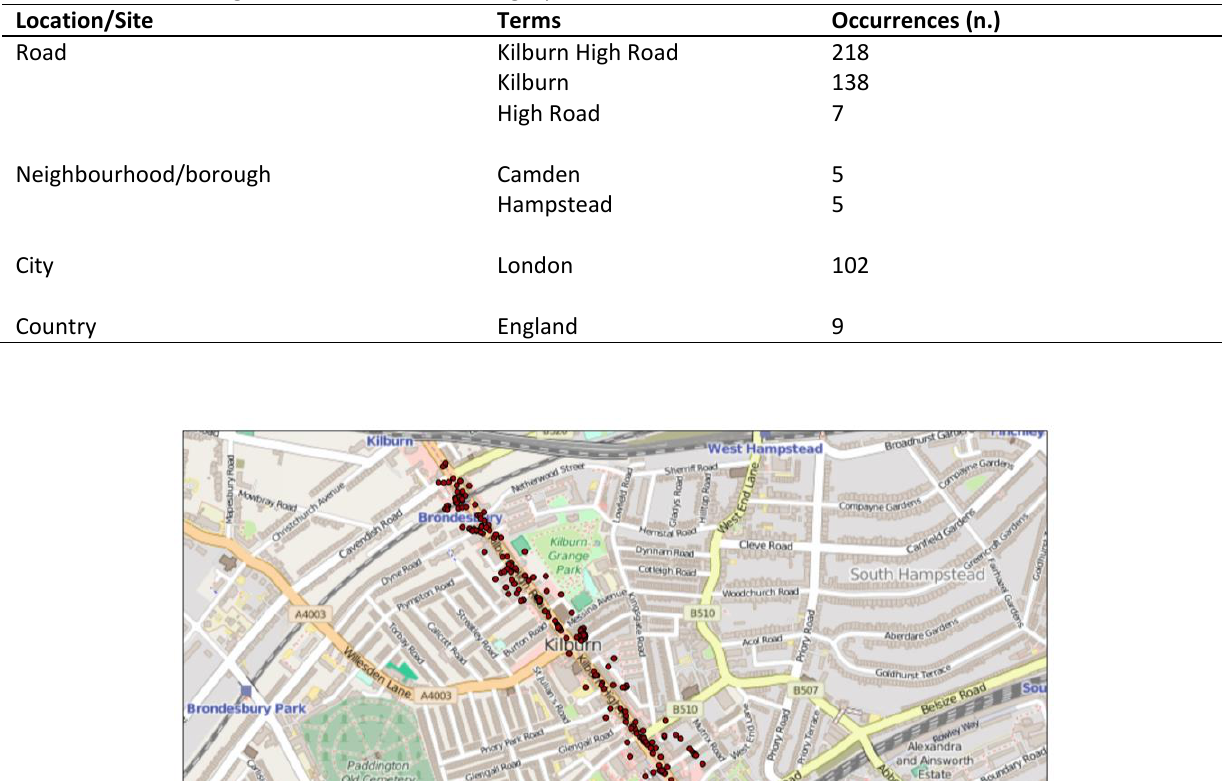
Table 2. Most recurring terms in the location category.